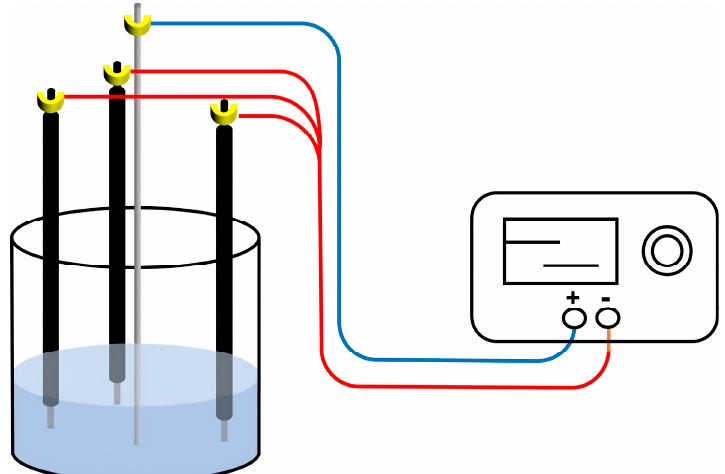
Figure 1. Schematic diagram of electrochemical etching device.